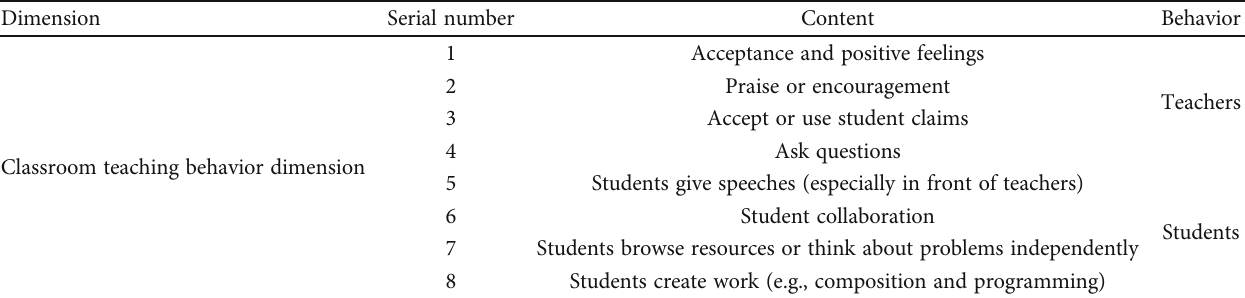
Table 1: Rules for coding classroom teaching